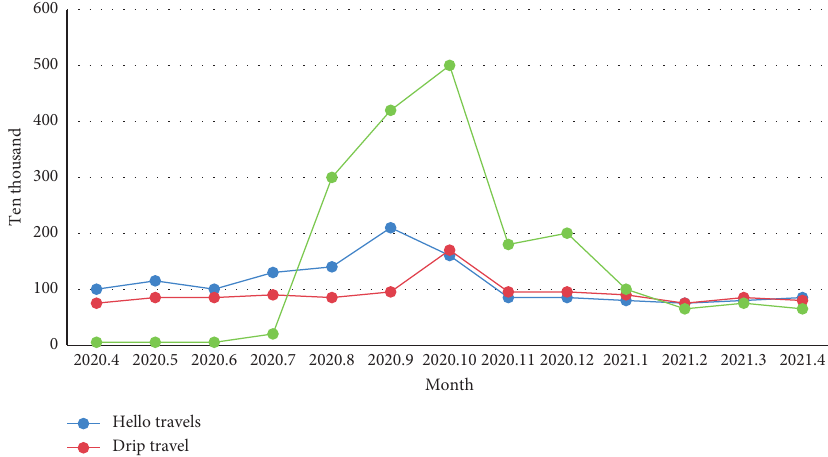
Figure 10: Platform information distribution of travel.